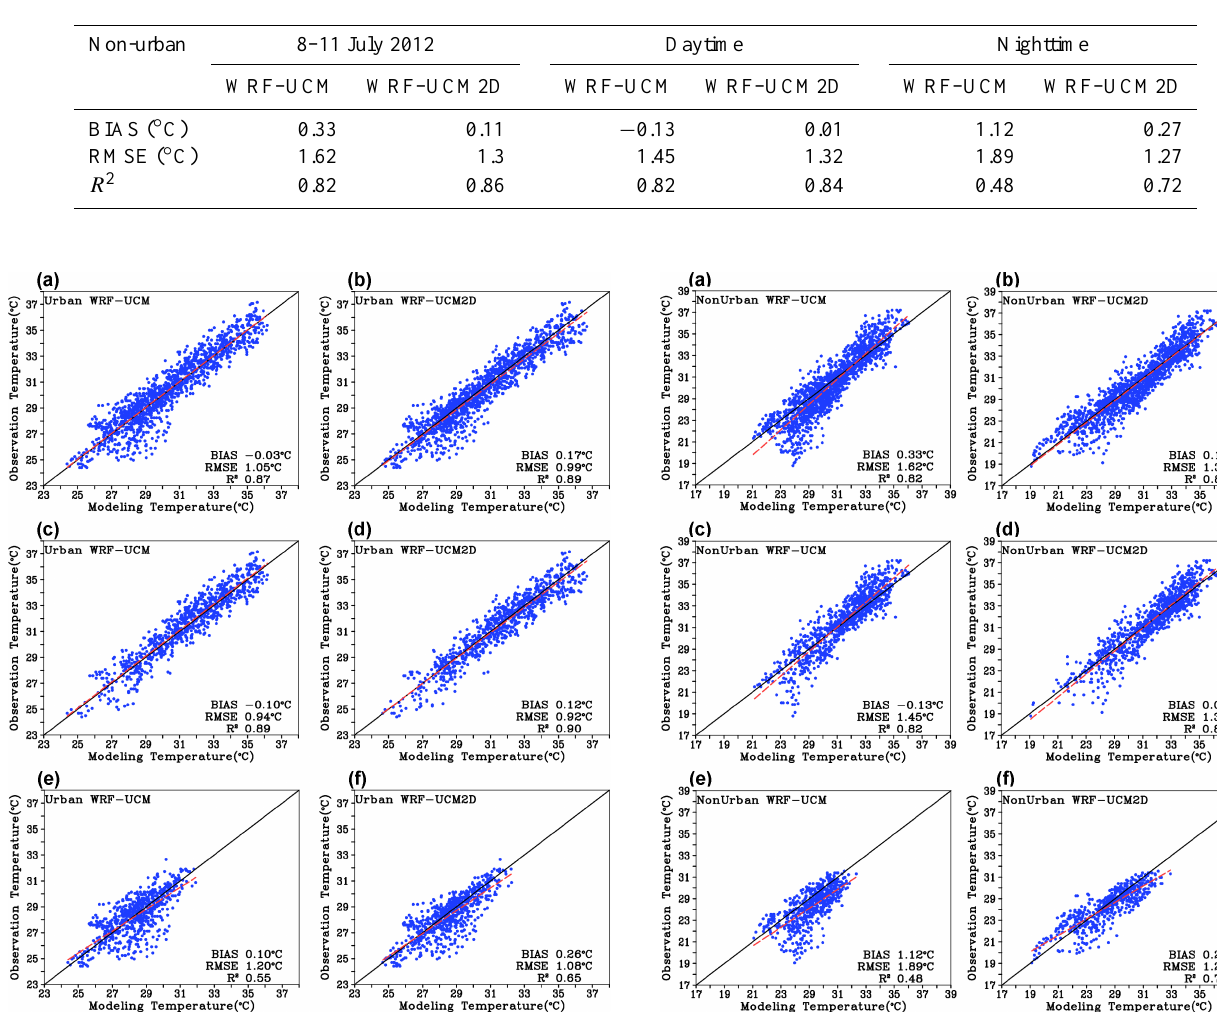
Figure 6. Scatterplots between observed and simulated tempera- tures at 21 non-urban stations with bias, RMSE, and R 2 calculated using simulated temperatures of (a, b) the entire study period, (c, d) daytime, and (e, f) nighttime obtained by WRF–UCM and WRF– UCM2D,